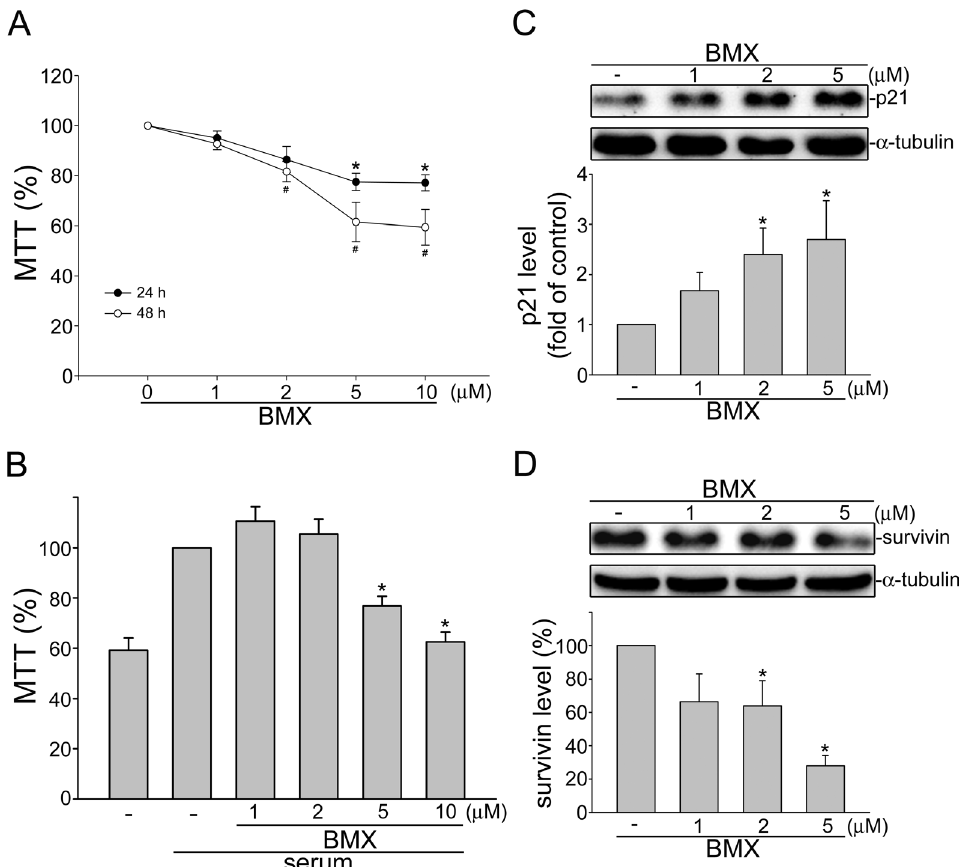
Figure 7. BMX inhibited serum-induced cell proliferation in HCT116 cells. (A) HCT116 cells were treated with vehicle or BMX at indicated concentrations for 24 or 28 h. Cell viability was then determined by MTT assay. Each column represents the mean 6 S.E.M. of seven independent experiments performed in duplicate. ( * p , 0.05 as compared with the vehicle-treated control group) (B) After starvation in serum free medium for 24 h, HCT116 cells were treated with indicated concentrations of BMX in the presence of serum (10% FBS) for another 24 h. Cell viability was then determined by MTT assay. Each column represents the mean 6 S.E.M. of five independent experiments performed in duplicate. ( * p , 0.05 as compared with the vehicle-treated control group in the presence of serum) Cells were treated for 24 h with vehicle or BMX at indicated concentrations. Protein levels of p21 (C) and survivin (D) were then determined by immunoblotting. Compiled results are shown at the bottom of the chart. Each column represents the mean 6 S.E.M. of five independent experiments. ( * p , 0.05 as compared with the vehicle-treated control